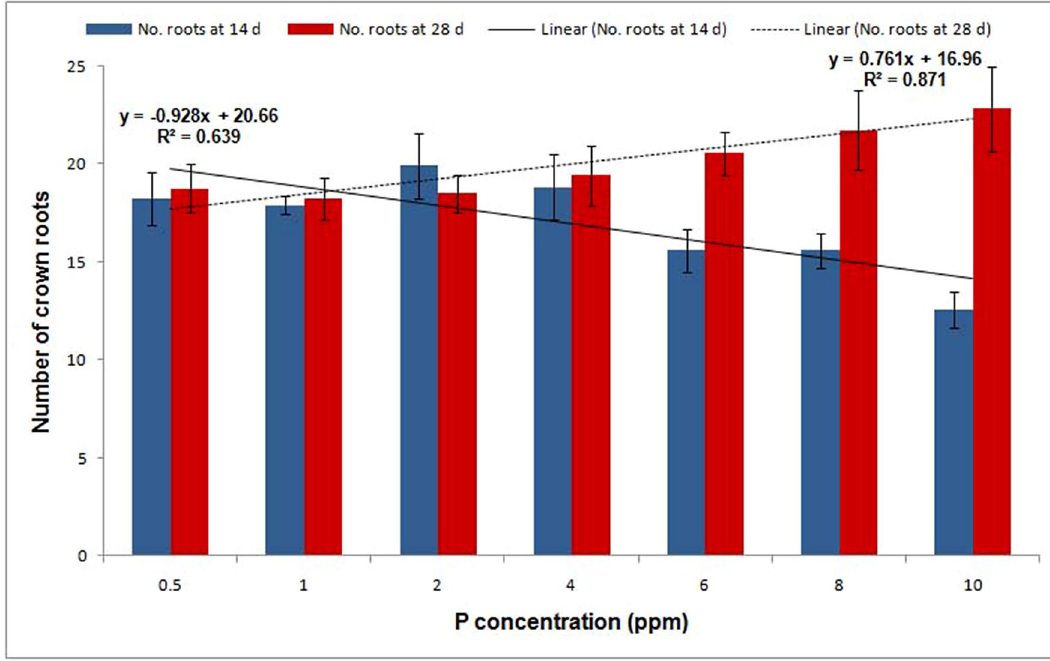
Figure 8. Average number of crown roots across genotypes under different concentrations of phosphorus in the hydroponic experiment at 14 d and 28 d. The vertical bar represents the standard